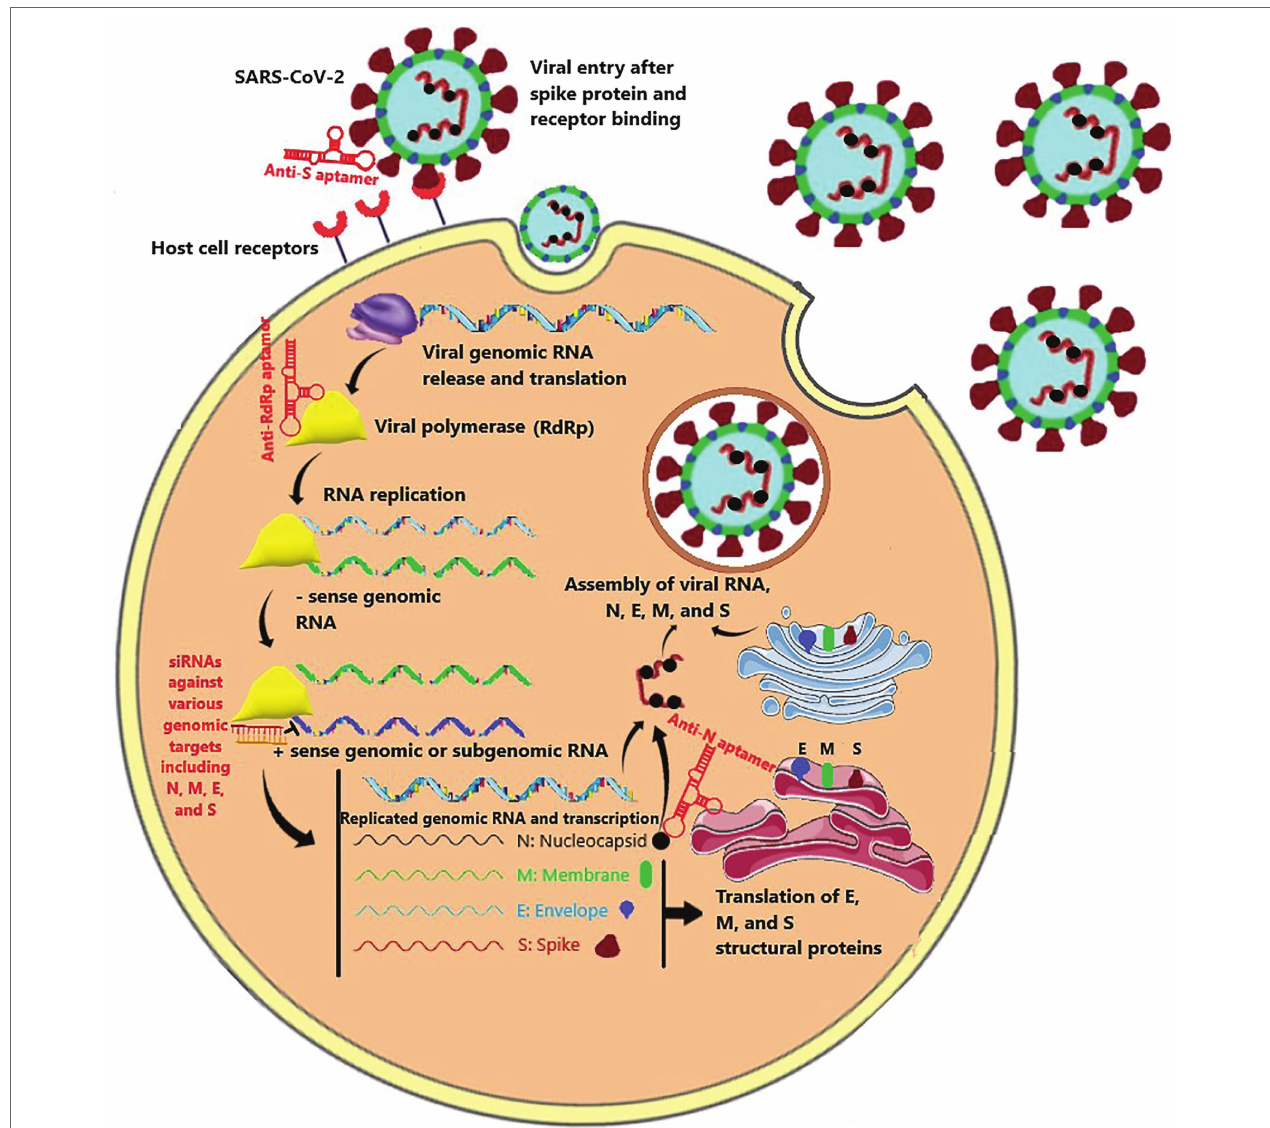
FIGURE 1 | The SARS-CoV-2 life cycle consisted of virus entry mediated by the spike protein, viral RNA replication mediated by RdRp polymerase, transcription and translation of nucleocapsid (N), envelope (E), membrane (M), and spike (S), and new virus assembly. Aptamers and siRNA could be directed against various stages of this life